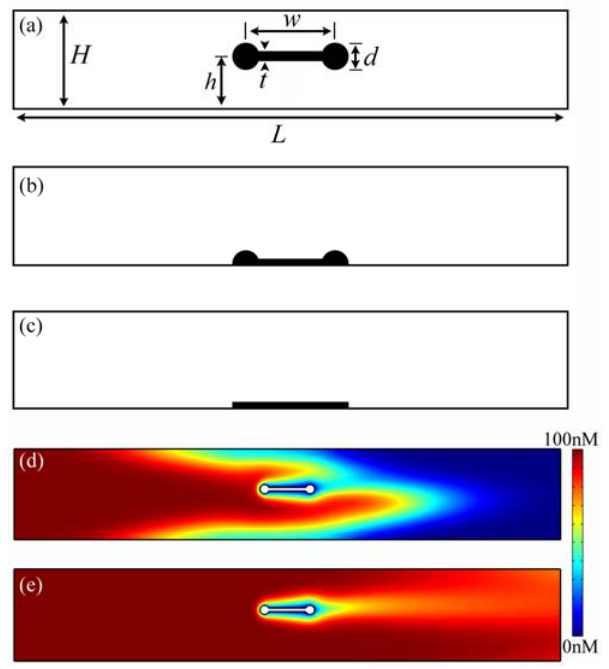
Figure 2. ( a ) Schematic of a 2-D cross-section of the flow cell and suspended optical waveguide sensor (not to scale). The sensor is located in the middle of the flow cell lengthwise. The flow cell height H = 50 μ m, length L = 300 μ m; waveguide